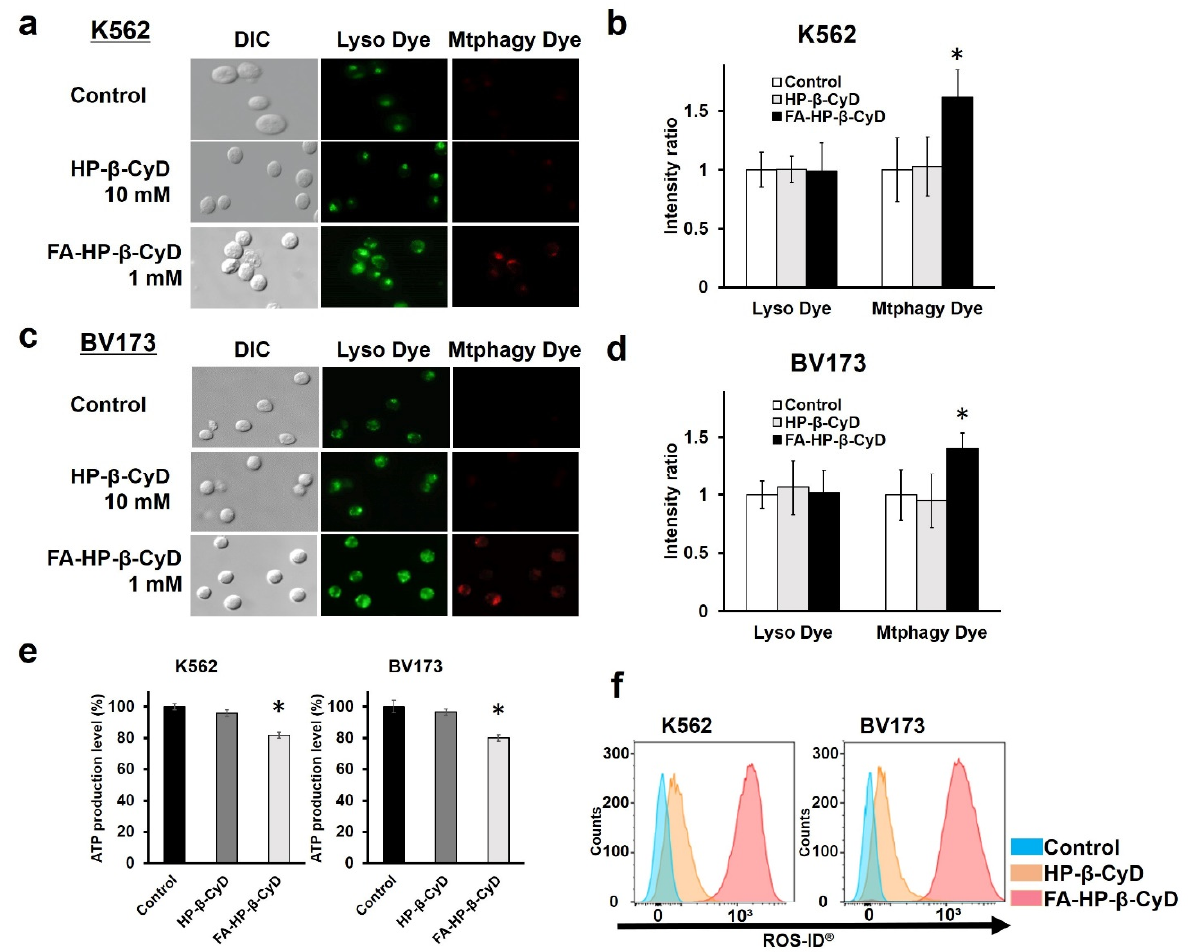
Figure 7. Detection of mitophagy, measurement of intracellular ATP levels, and ROS generation assay in CML cells. ( a and c ) Detection of mitophagy in K562 and BV173 cells. The cells were treated with Mtphagy dye, a mitophagy detection reagent, and then incubated with medium only (control), 1 mM of FA-HP- β -CyD, and 10 mM of HP- β -CyD, followed by Lyso dye, a lysosome detection reagent. Representative images are shown ( n = 3). ( b and d ) Fluorescence intensities of Mtphagy dye and Lyso dye in the control, in HP- β -CyD-treated, and in FA-HP- β -CyD-treated cells are shown in bar graphs. * p < 0.05 compared with the control. ( e ) Measurement of intracellular ATP levels. K562 and BV173 cells were incubated with medium only (control), 1 mM of FA-HP- β -CyD, and 10 mM of HP- β -CyD for 2 h. Then, the cells were treated with ATP detection reagent. Bar graphs represent the mean ± SEM ( n = 3 per group). * Significant difference with p < 0.05 compared with the control and FA-HP- β -CyD. ( f ) ROS generation assay. K562 and BV173 cells were incubated with medium only (control), 1 mM of FA-HP- β -CyD, and 10 mM of HP- β -CyD, and detected by flow cytometry using ROS detection reagents. Blue: control; orange: HP- β -CyD; and red: FA-HP- β -CyD.